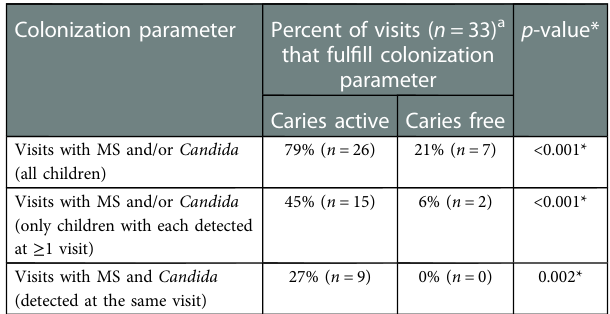
TABLE 4 Co-colonization of MS and Candida and its association with